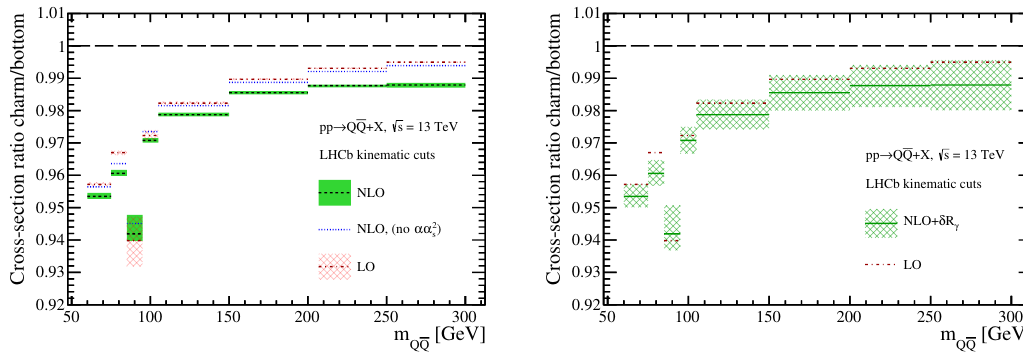
Figure 5 . Ratio between the di(cid:11)erential cross section of c - and b -jet pair production at the 13 TeV LHC. Left: LO and NLO distributions for (cid:22) 0 = m , as well as the NLO distribution Q (cid:22) Q obtained without the O ( (cid:11)(cid:11) 2 ) corrections. Right: NLO distribution obtained with (cid:22) 0 = m , where Q (cid:22) Q s an additional uncertainty due to photon-induced contributions has been included as explained in the main text. The central value of the LO distribution is also shown for